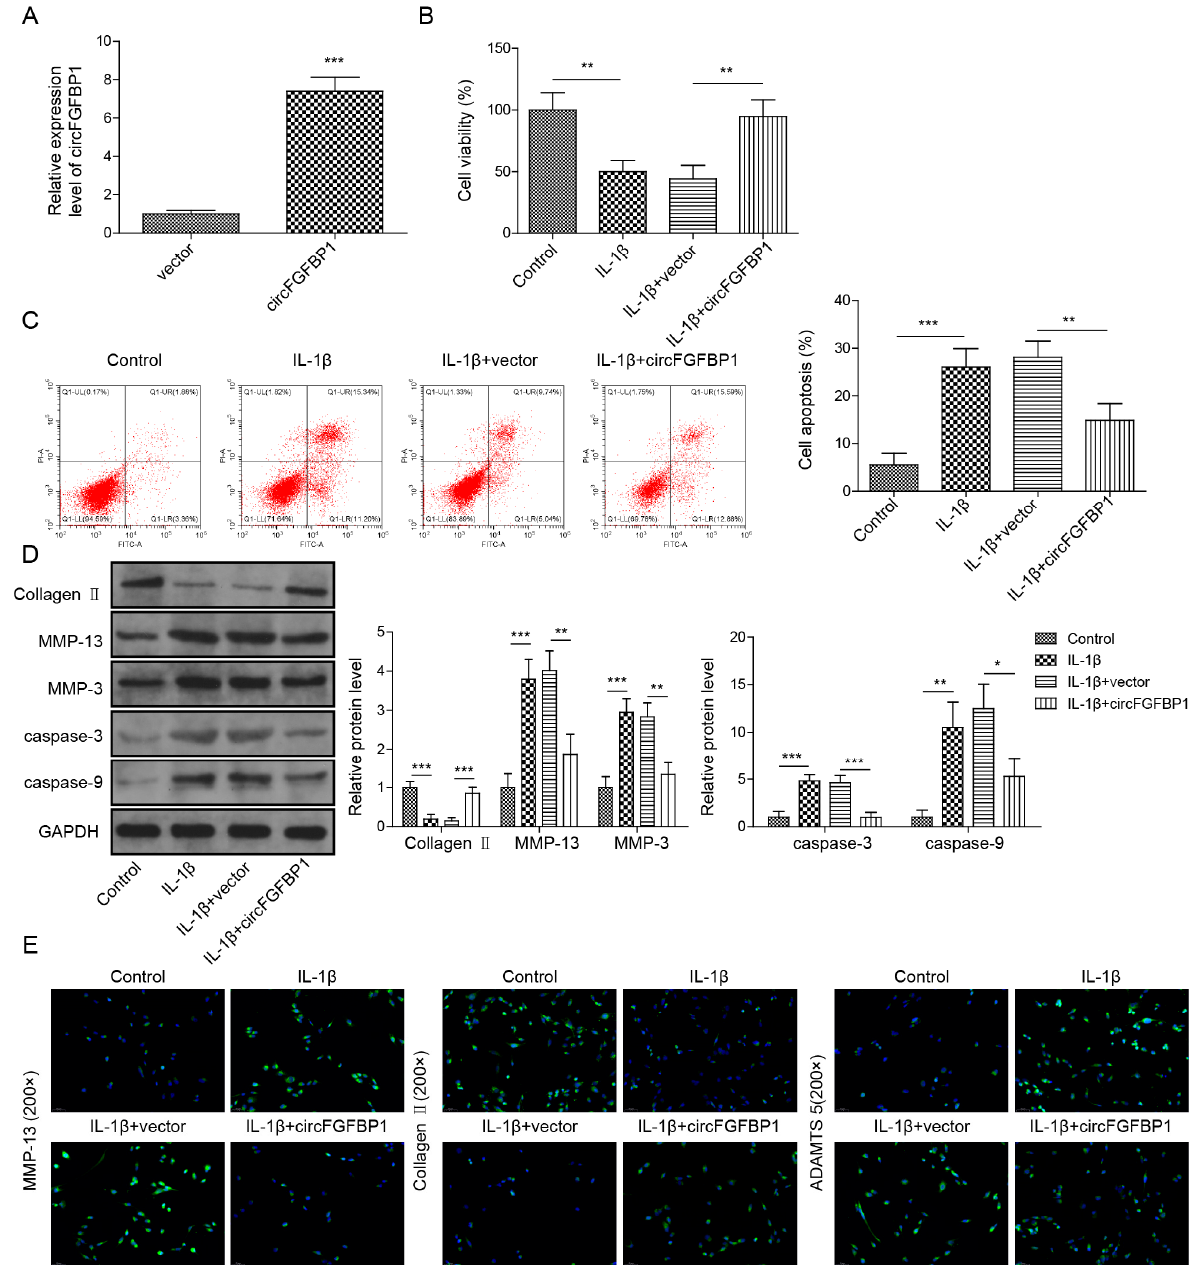
Figure 3. Overexpression of circFGFBP1 prevents apoptosis and ECM degradation in NP cells. ( A ) CircFGFBP1 expression by qPCR. ( B ) Cell viability by CCK-8 assay. ( C ) Apoptosis in NP cells by flow cytometry. ( D , E ) Expressions of ECM proteins by Western blot ( E ) and immunofluorescence ( E ). Data were estimated as mean ± SD. * p < 0.05, ** p < 0.01, *** p < 0.001.